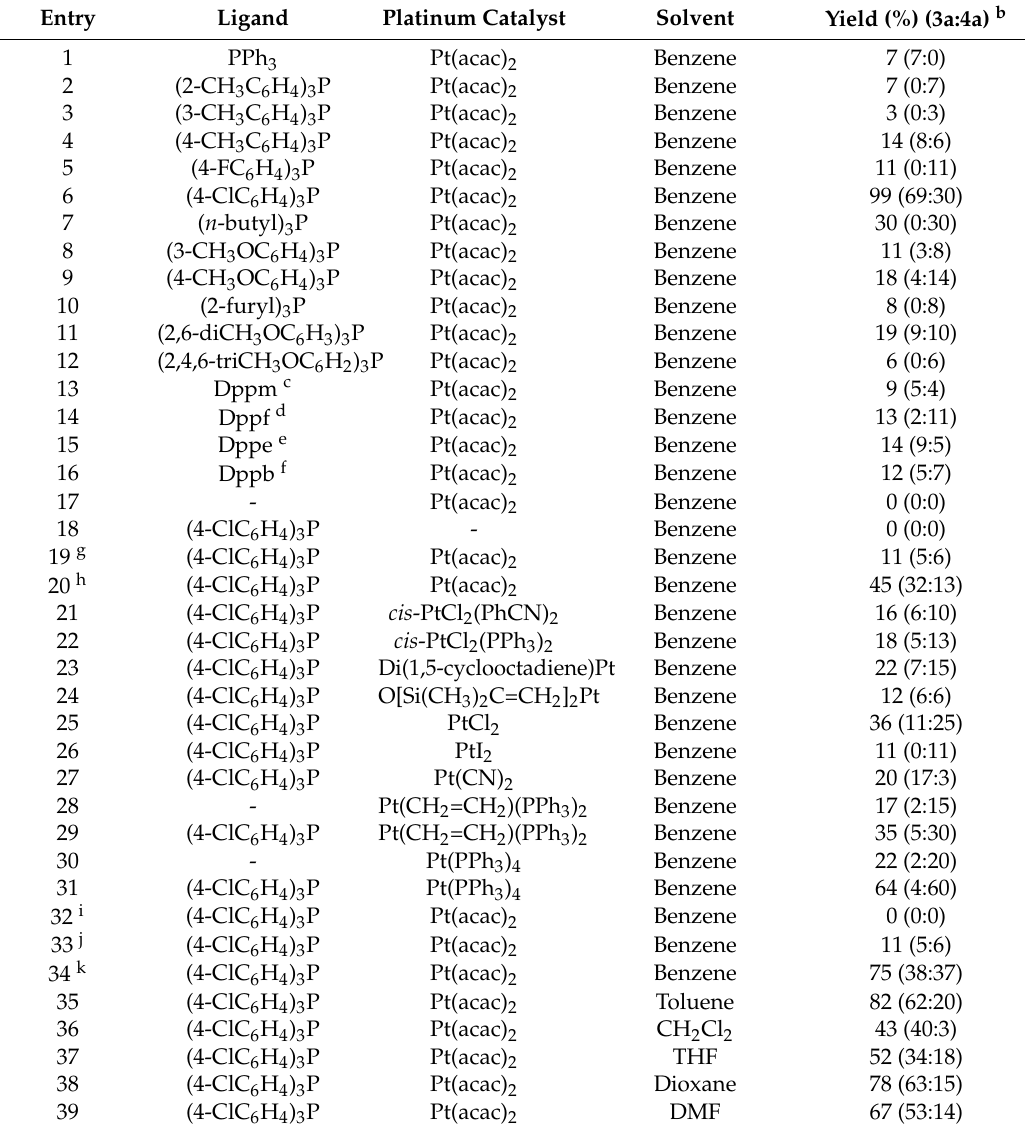
Table 1. Reaction of 1,2,3,4-tetrahydrocarbazole ( 1a ) with allyl acetate ( 2a ).